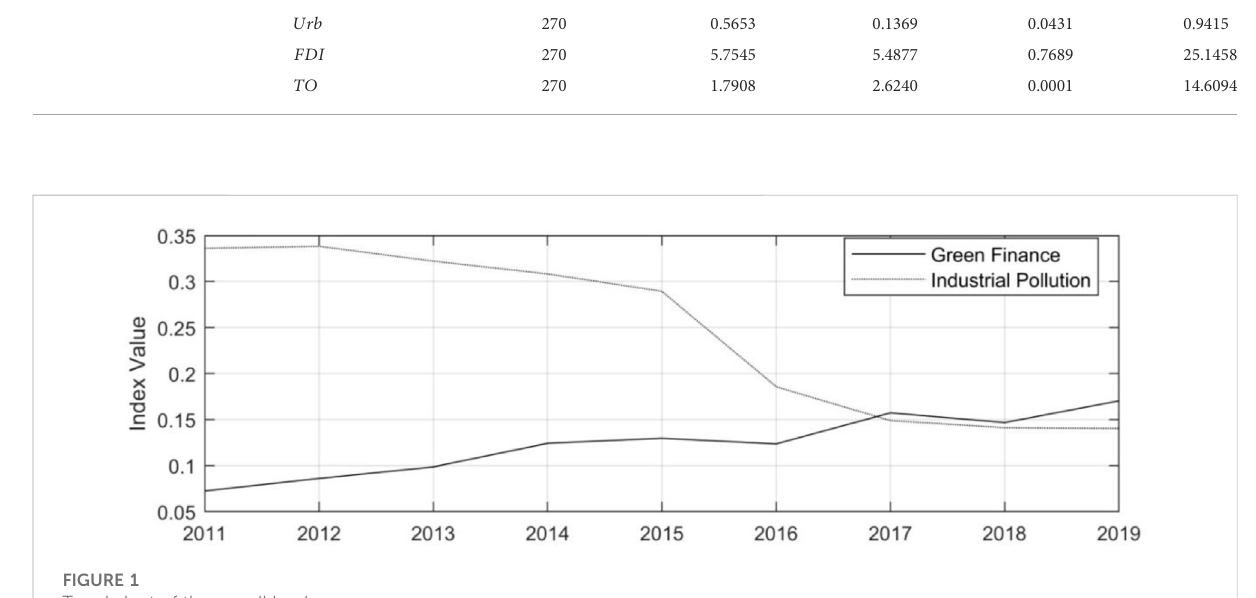
FIGURE 1 Trend chart of the overall